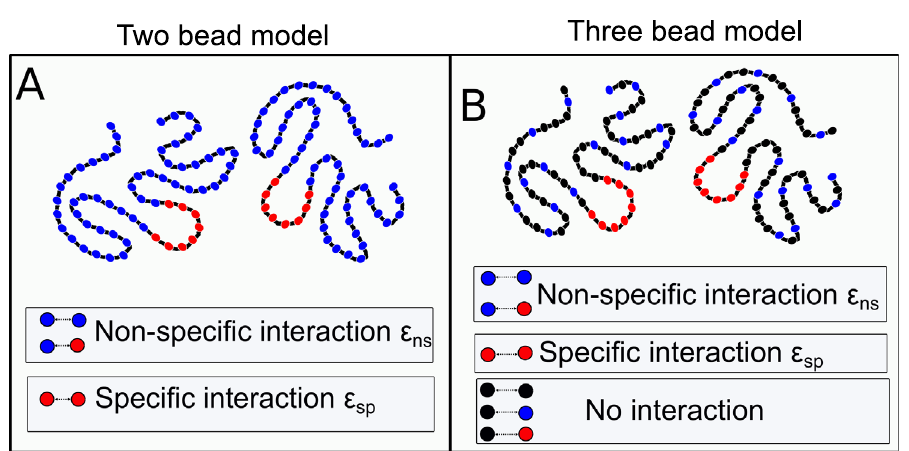
Fig 1. Bead-spring polymer model of protein. A) Chains consist of a central “functional” patch (red) surrounded by other beads which make up non-specifically interacting regions (blue). B) Three bead polymers with black beads representing non-interacting residues (only repulsive interaction), in addition to specifically (red) and non-specifically (blue) interacting residues. Specific and non-specific interaction strengths are represented by � sp and � ns , respectively, with � sp > � ns . We employ the 3-bead model to vary the fraction of non-specifically interacting residues, while keeping the polymer length